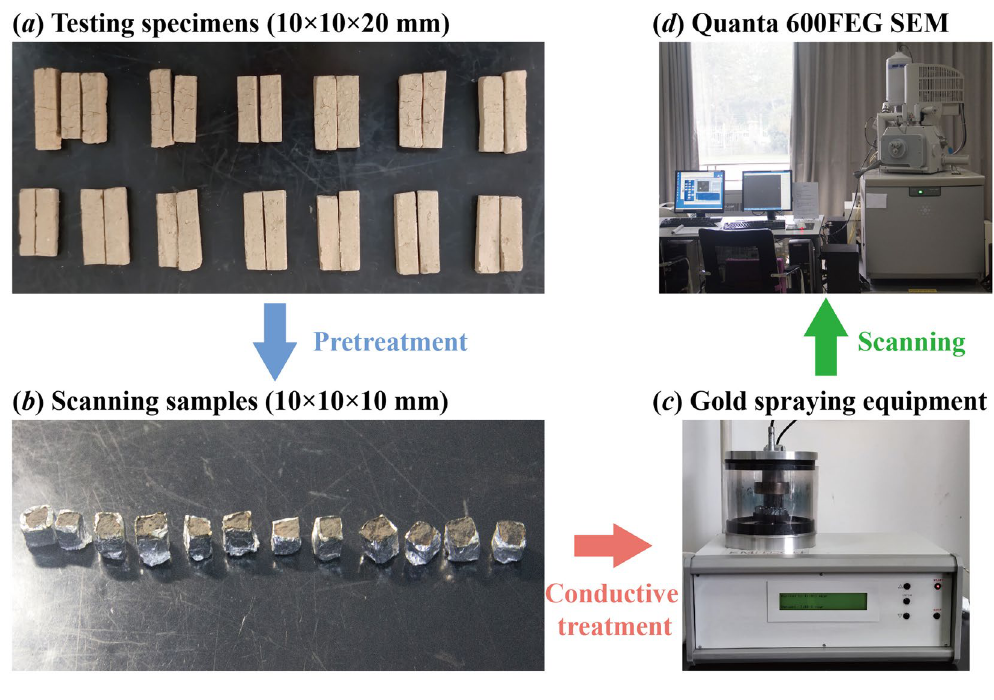
Figure 4. SEM test